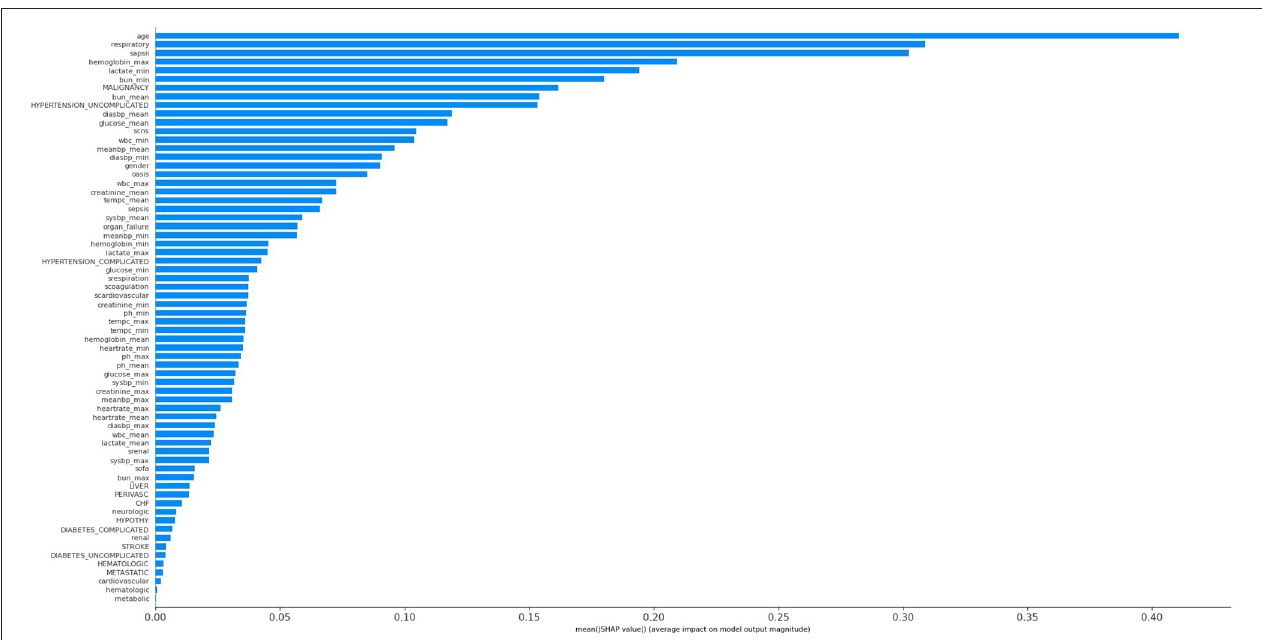
FIGURE 4 | Significance of the predictors in the XGBoost model. CHF, chronic heart failure; Diabetes_complicated, diabetes with complication; Diabetes_uncomplicated, diabetes without complication; Diasbp, diastolic blood pressure; Hypertension_complicated, hypertension with complication; Hypertension_uncomplicated, hypertension without complication; OASIS, Oxford Acute Severity of Illness Score; Organ_failure, any organ failure; Perivasc, perivascular disease; SAPS II, Simplified Acute Physiology Score II; sCardiovascular, severe cardiovascular failure; sCNS, severe central nervous system failure; sCoagulation, severe coagulation failure; SOFA, Sequential Organ Failure Assessment; sRenal, severe renal failure; sRespiration, severe respiratory failure; Sysbp, systolic blood pressure; Tempc, temperature; WBC, white blood cell.